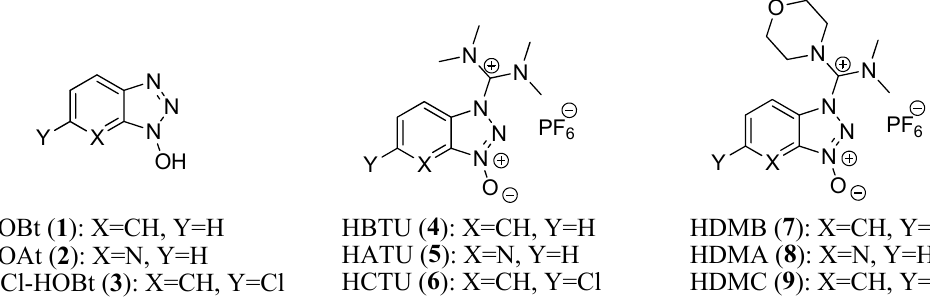
Figure 1. Structure of 1-hydroxybenzotriazoles and their aminium